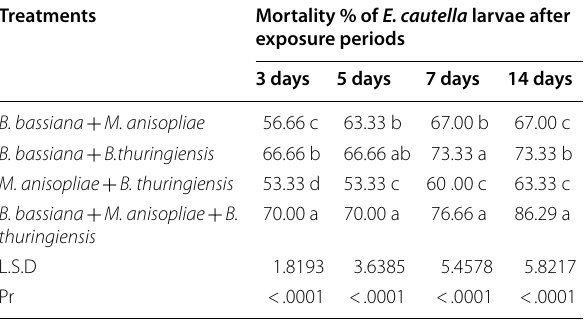
Table 4 Effects of LC combined values of Beauveria bassiana , 50 Metarhizium anisopliae and Bacillus thuringiensis on the percentage mortality of Ephestia cautella larvae